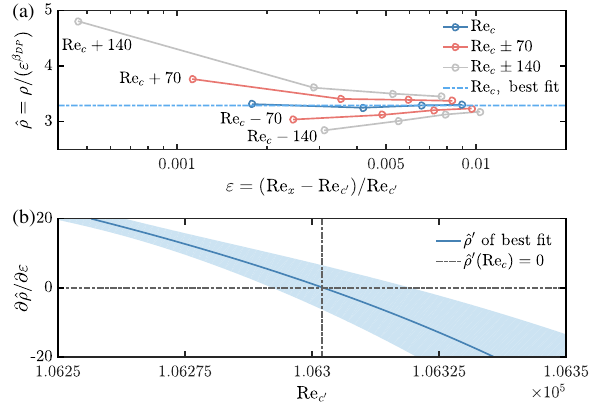
FIG. 8. (a) Rescaled turbulent fraction ˆ ρ as a function of ε for a variety of possible critical Reynolds numbers, Re c 0 ∈ ½ Re ; Re (cid:3) 75 ; Re (cid:3) 150 (cid:2) . Where ˆ ρ becomes constant, Re c c c can be estimated best. (b) Derivative of ˆ ρ as a function of Re c 0 including standard errors. The critical Reynolds number is determined by the zero crossing of ˆ ρ 0 . The uncertainty of Re c is estimated by propagation of errors. Here, TI